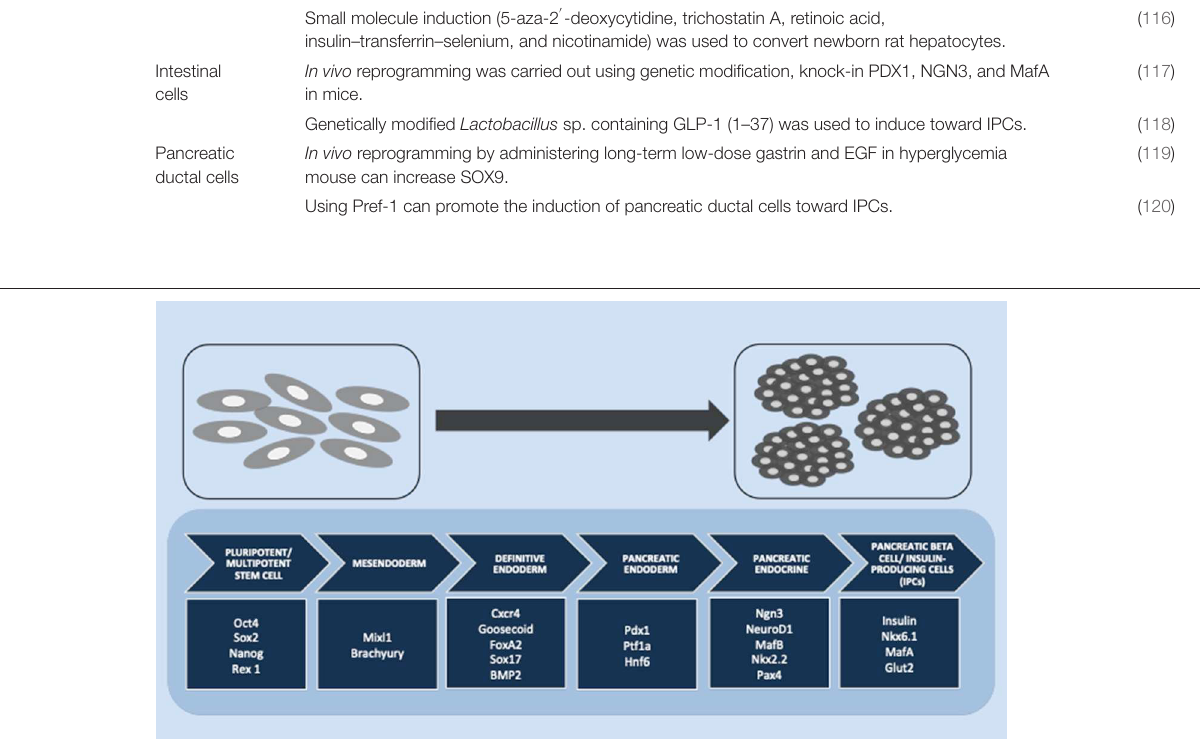
Frontiers in Veterinary Science |